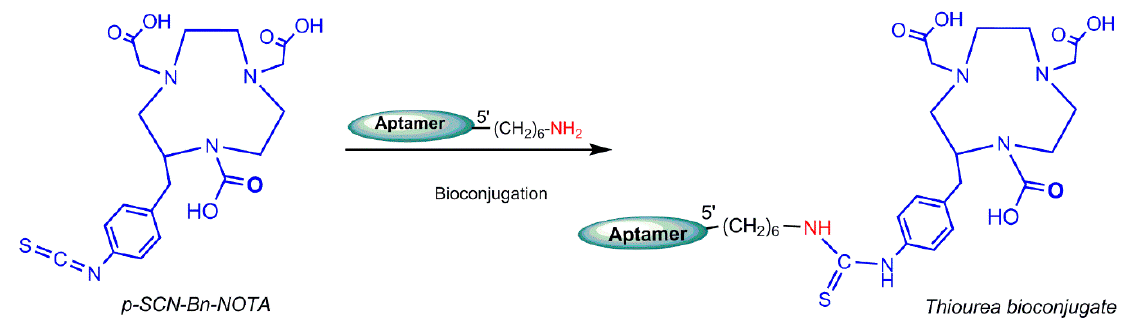
Figure 19. Amine–isothiocyanate bioconjugation reaction of isothiocyanate (SCN)–Bn–1,4,7 ‐ triazacyclononane– N , N ′ , N ′′ –triacetic acid (NOTA) to a hexylamine ‐ functionalized oligonucleotide.